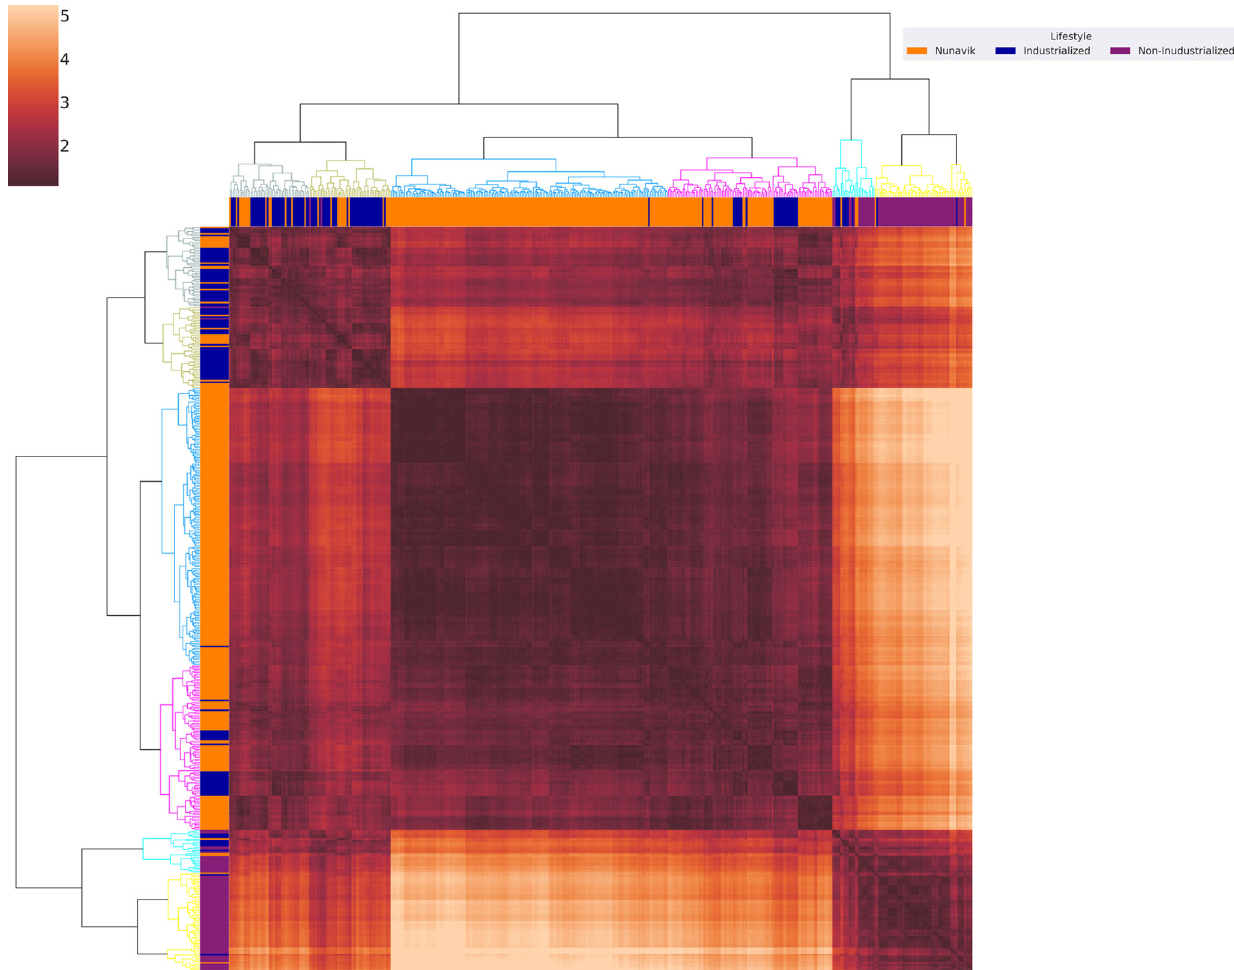
Fig. 3 k-mer content clusters Nunavik gut microbiomes. The heatmap represents the Euclidean distance between k-mer genomic content of Nunavik and comparison samples, as computed by Ray Surveyor. Dendrograms on the X and Y axes of the heatmap represent metagenomic samples ordered based on hierarchical clustering of k-mer content distance matrix. At the leaves of the dendrograms are colored markers of each sample ’ s population (see legend). Within the heatmap, the darker the shade of red, the higher the similarity between metagenomes. At the top left of the heatmap, the dark red square represents the industrialized cluster and indicates that samples from the gray and khaki dendrogram branches are similar in genomic content. The two branches are composed of 69.4% and 70% of industrialized samples, respectively. Similarly, the dark red color in the center of the heatmap de fi nes the Nunavik cluster, where the blue branch consists of 99.4%, and the pink of 76.2 % samples from Nunavik. Lastly, the bottom right square constitutes the non-industrialized cluster, with the light blue and yellow branches composed of 57.7% and 93.3% of non-industrialized samples